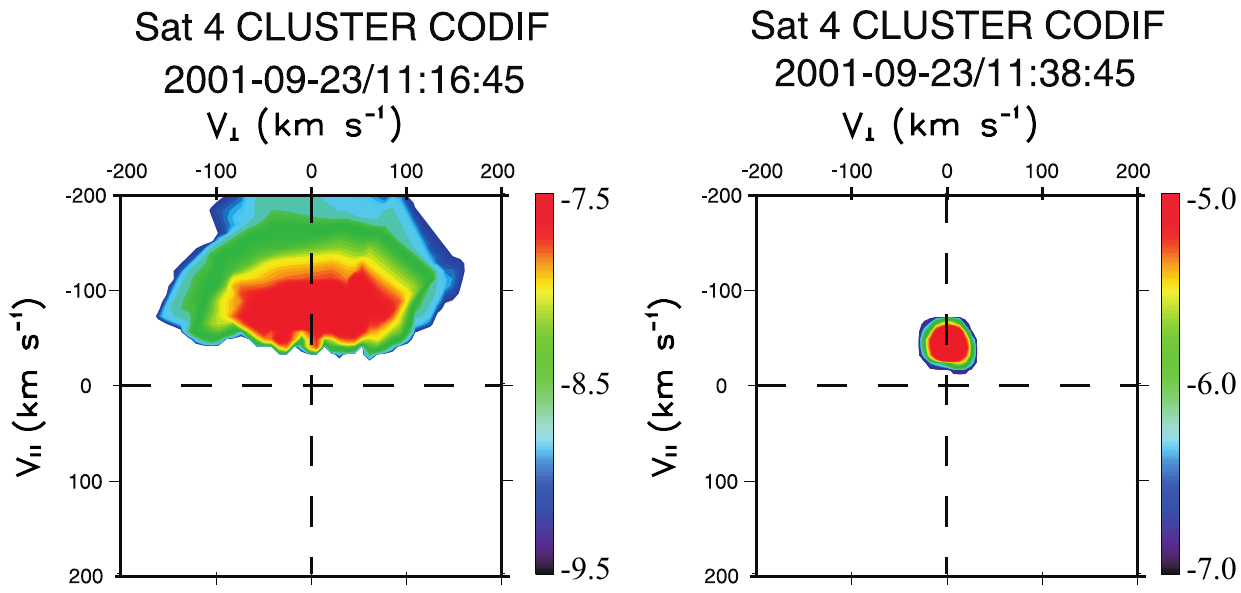
Fig. 3. Two-dimensional cuts in the V ⊥ -V // plane of oxygen velocity distributions in Log[cm − 3 km − 3 s 3 ] measured by C4 at 11:16:45 UT (left) and 11:38:45 UT (right) on 23 September